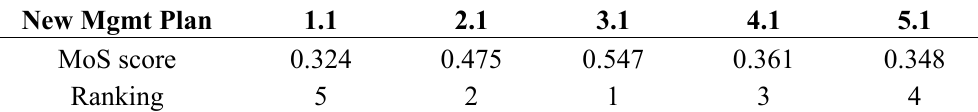
Table 10. MoS Scores and rankings of adjusted management